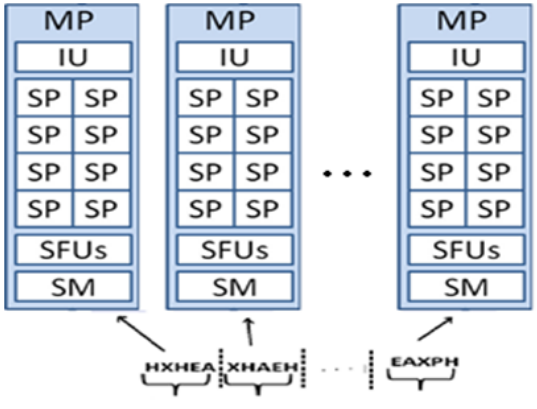
Figure 7: Boundary problem in PFAC